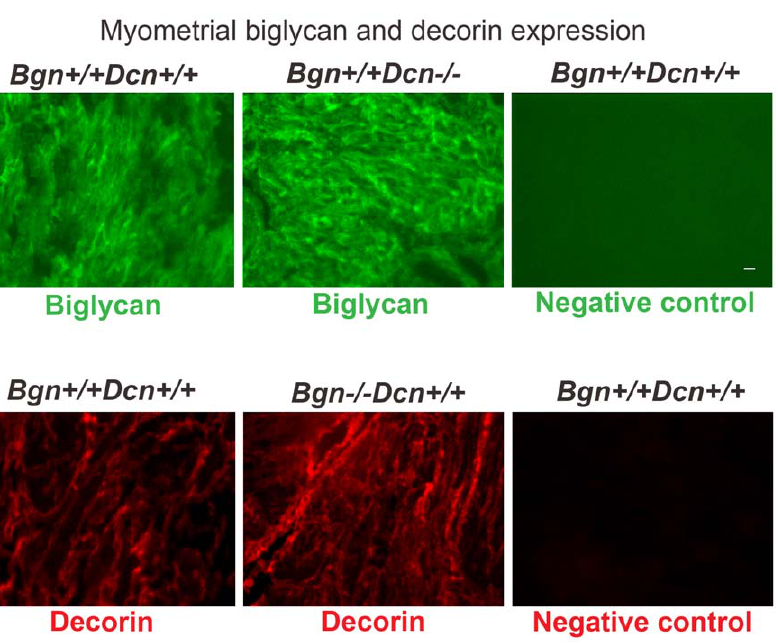
Figure 7. Altered TGF- b expression in biglycan knockout mice. A: TGF- b expression was evaluated in uterine samples of pregnant dams at E18. Western blotting was performed on wild-type, Bgn 2 / 2 Dcn + / + and Bgn + / + Dcn 2 / 2 uteri. GAPDH was used as an internal standard. B: TGF- b is decreased in the absence of biglycan. Digitally scanned and densitometrically analyzed Western blots from three experiments from three individual mouse uteri are expressed as a ratio of TGF- b over GAPDH and normalized to the wild-type ratio. Student’s t-test. P =0.004 for biglycan knockout; P =0.46 for decorin knockout. Error bars=SD.